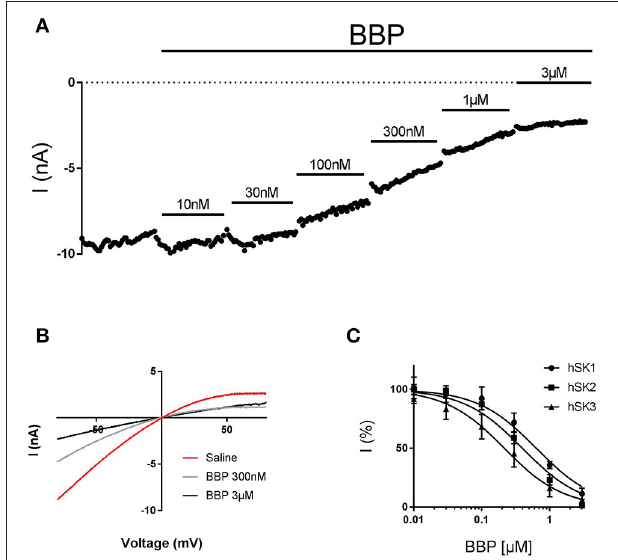
FIGURE 2 | Inhibitory effect of BBP on hSK channels. Representative current-time plot (A) and its corresponding current-voltage plot (B) from automated patch clamp experiments picturing the inhibitory effect of BBP at different increasing concentrations performed on hSK3-expressing cells. The compound completely inhibited SK currents at concentrations of 1–3 µ M. (C) Depicts the inhibition curves of BBP on each of the hSK subtype channels Resulting IC 50 were 0.7 ± 0.2 µ M for hSK1 ( n = 9), 0.4 ± 0.1 µ M for hSK2 ( n = 8) and 0.4 ± 0.2 µ M for hSK3 ( n =